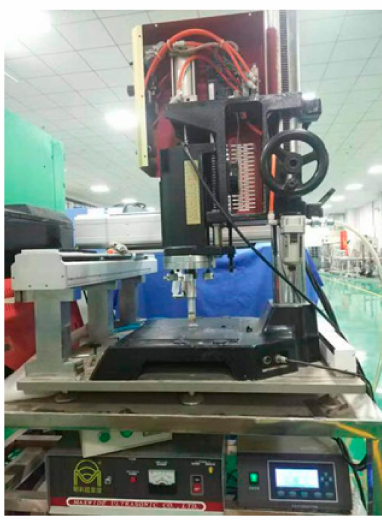
Figure 4. Experiment platform for the ultrasonic treatment.